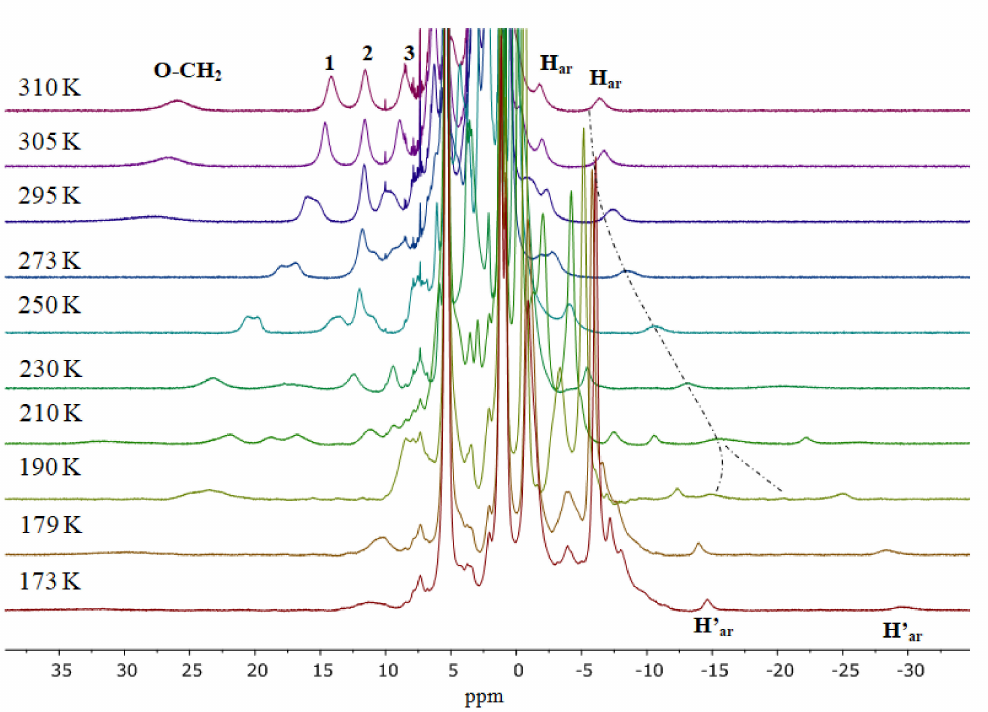
Figure 2. 1 H NMR spectra of Co calix[4]arene at different temperature in CDCl 3 /CD 2 Cl 2 . Dashed lines indicate trends in the temperature dependence of the H’ ar (H ar ) signals of form A ( B ) upon chemical